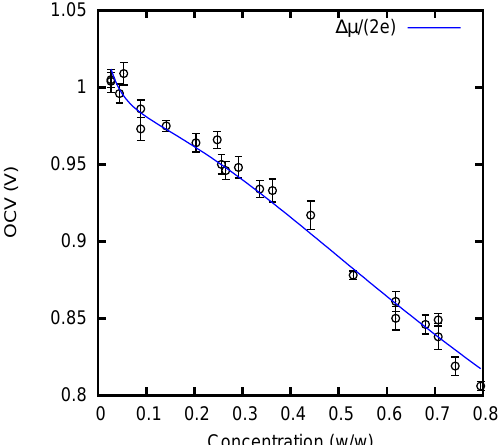
Figure 6. The cell voltage as a function of the concentration. The voltage is measured in an open circuit. Two independent sets of measurements are shown. Four measurements are performed and averaged; the error bars represent the observed standard deviation. The solid line has been obtained from the chemical potential, in turn calculated from the boiling point